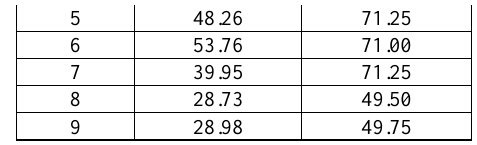
Table 4. Comparison of MPV from analysis and survey